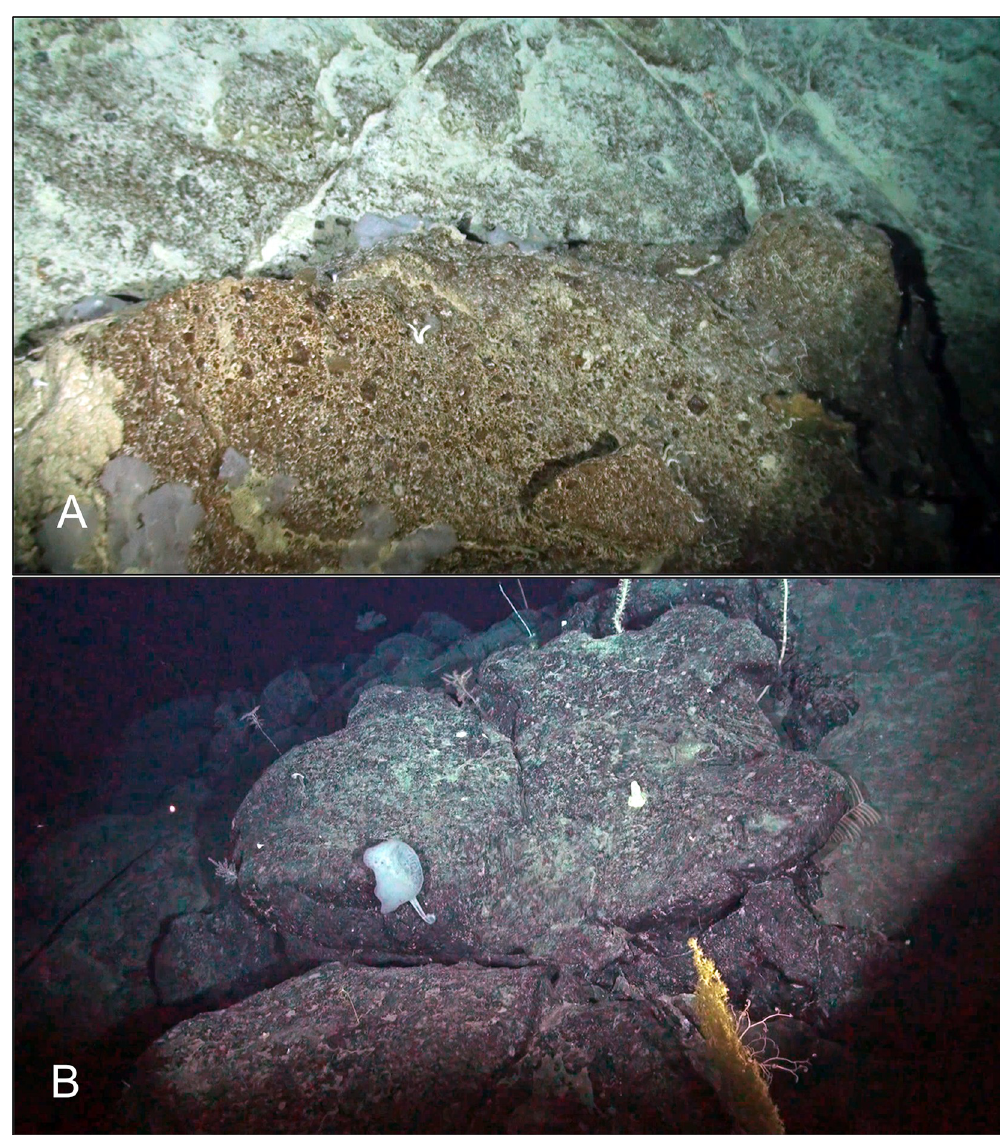
Fig 5. Vulnerable marine ecosystem indicator taxa, including deep-sea corals and sponges, observed on deep-sea camera deployments along the Salas y Go´mez and Nazca ridges. (A) Sala y Go´mez—552 m (B) Desventuradas– 1,714 m. MaxN was highest in Desventuradas soft bottom habitats and lowest in RN/SyG soft bottom habitats. Fish assemblage structure was significantly different between subregions (PERMANOVA pseudo-F = 2.482, p = 0.022) but not between habitats (PERMANOVA pseudo-F = 1,43 1,43 1.431, p = 0.184) or their interaction (PERMANOVA pseudo-F = 1.974, p = 0.059). The 1,43 average dissimilarity between subregions was 91.01%. Squalidae accounted for the greatest dis- similarity between subregions (18.27%), with abundances at Desventuradas ( � X = 2.26 ± 2.49) an order of magnitude greater than at RN/SyG ( � X = 0.21 ± 0.54) (Table 2). Moridae accounted for an additional 7.98% of the dissimilarity between subregions, with abundances at Desven- turadas ( � X = 0.63 ± 1.04) 42% higher than at RN/SyG ( � X = 0.26 ± 0.56). Abundances of